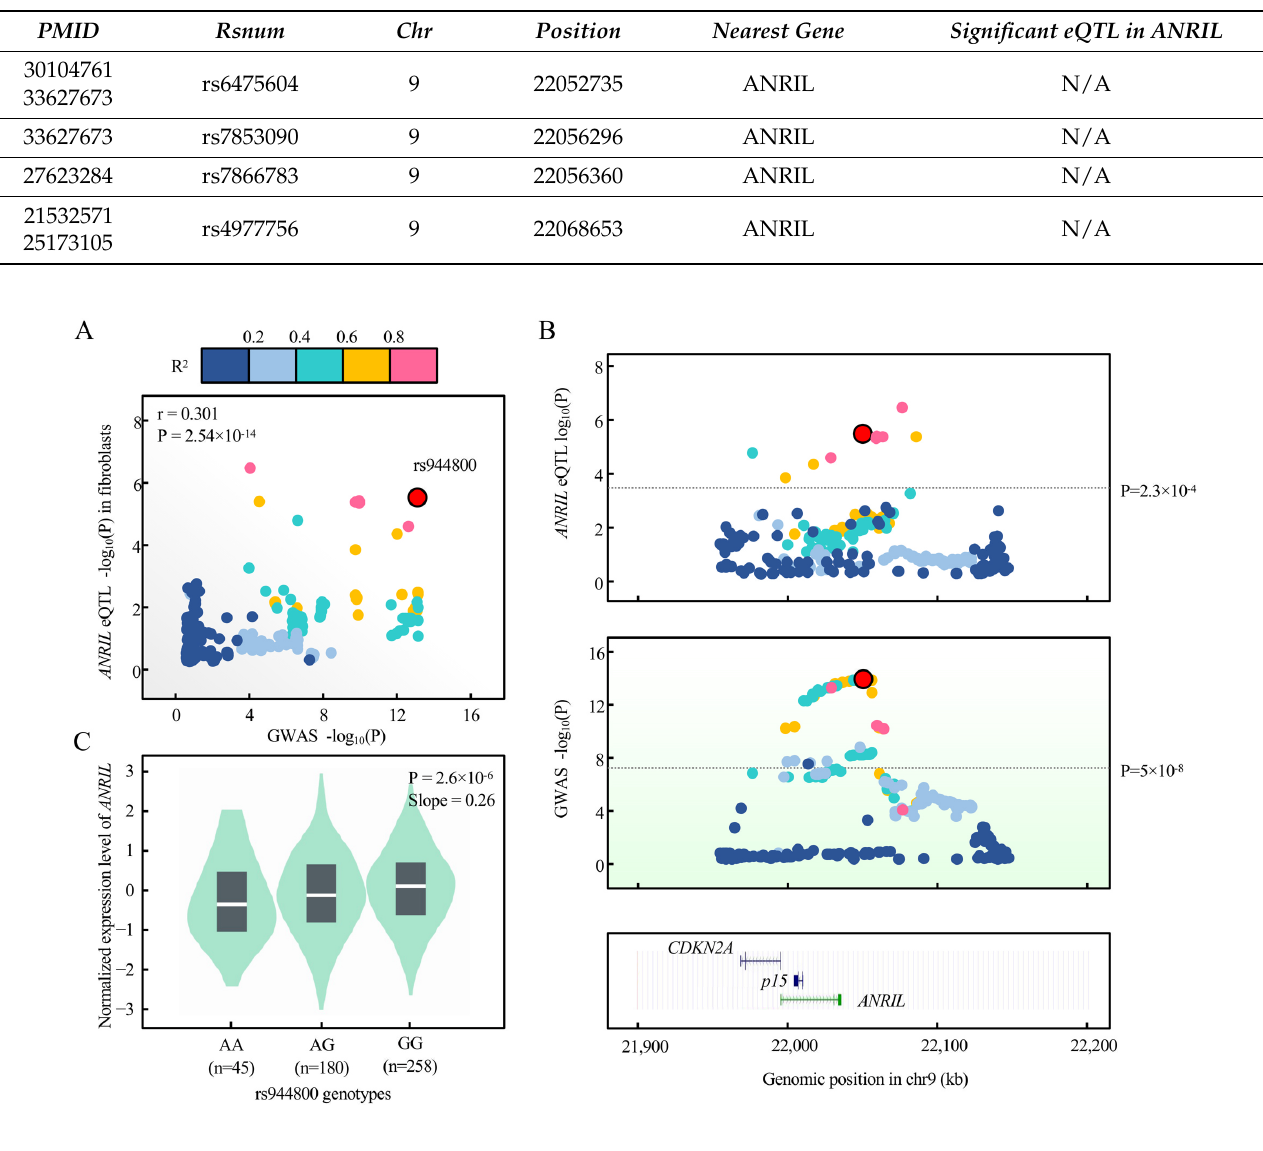
Figure 8. Colocalization between glaucoma risk variant rs944800 and expression of ANRIL in GTEx. ( A ) eQTL signal in GTEx v8 fibroblast cells ( n = 483) for ANRIL colocalizes with that of glaucoma GWAS on the lead variant, rs944800 by coloc (PPH 4 = 0.688). Pearson correlation is shown between log-transformed p values of eQTL ( y -axis) and GWAS ( x -axis). Variants are color-coded based on the LD R 2 (1000 Genomes, EUR, phase 3) with the candidate variant (red dot, rs944800). ( B ) Regional association plots of eQTL (blue shadow) and GWAS (green shadow) within +/ − 100 kb of rs944800 are presented. The horizontal line indicates genome-wide significant p -value for GWAS (5 × 10 − 8 ) and genome-wide empirical p -value threshold for eQTL of ANRIL (2.3 × 10 − 4 ). UCSC tracks of gene and annotation are displayed as the full mode in this region. ( C ) eQTL violin plots were directly adopted from GTEx v8 data through GTEx portal (gtexportal.org). p -value and slope (relative to G allele in rs944800, which is the glaucoma protective allele) were derived from linear regression with no multiple-testing